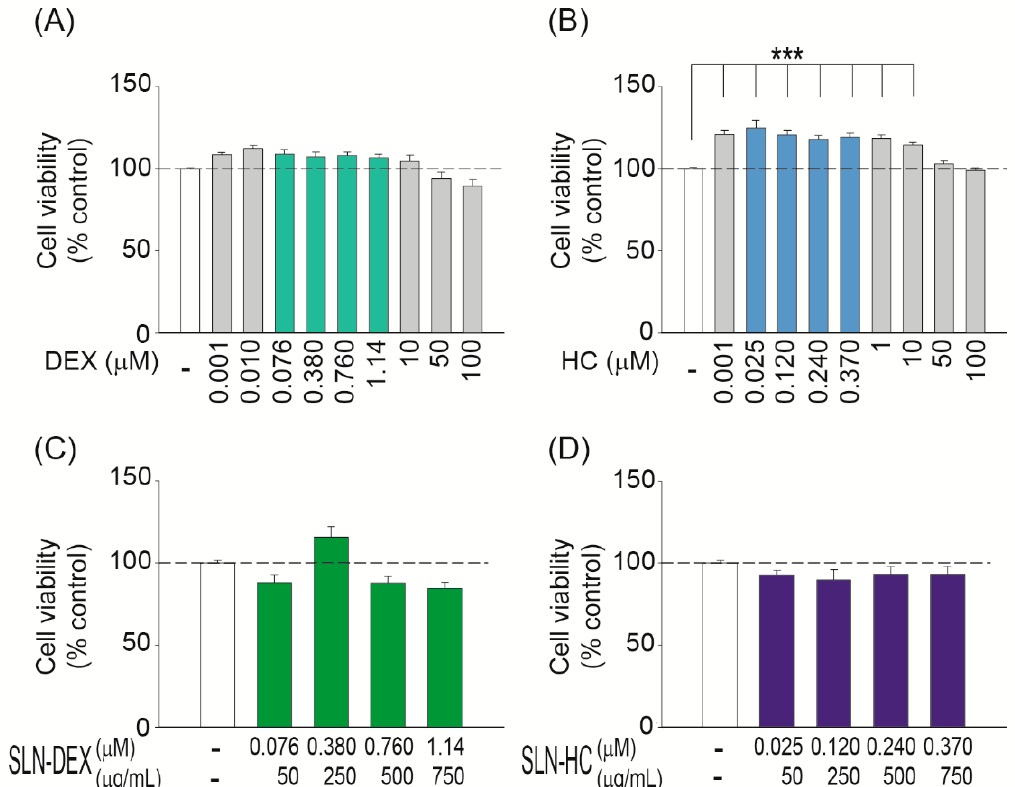
Figure 4. Di ff erential e ff ects of free versus SLN-incorporated glucocorticoids on HEI-OC1 viability. Cell viability of HEI-OC1 treated with di ff erent concentrations of dexamethasone (( A ), grey or pale green), hydrocortisone (( B ), grey or pale blue), SLN–DEX (( C ), dark green) or SLN–HC (( D ), dark blue) over 24 h. The a and b green and blue bars also correspond to the doses tested for dexamethasone or hydrocortisone incorporated into SLN in ( C ) and ( D ), respectively. Cell viability was analyzed using the XTT assay as described in the Methods section. Results are shown as mean ± SEM. ( A – B ) data were obtained from two independent experiments performed in quadruplicate, whereas ( C – D ) data were obtained from two-four independent experiments performed in quadruplicate. The significance of the di ff erences was evaluated using one-way ANOVA testing; *** p <